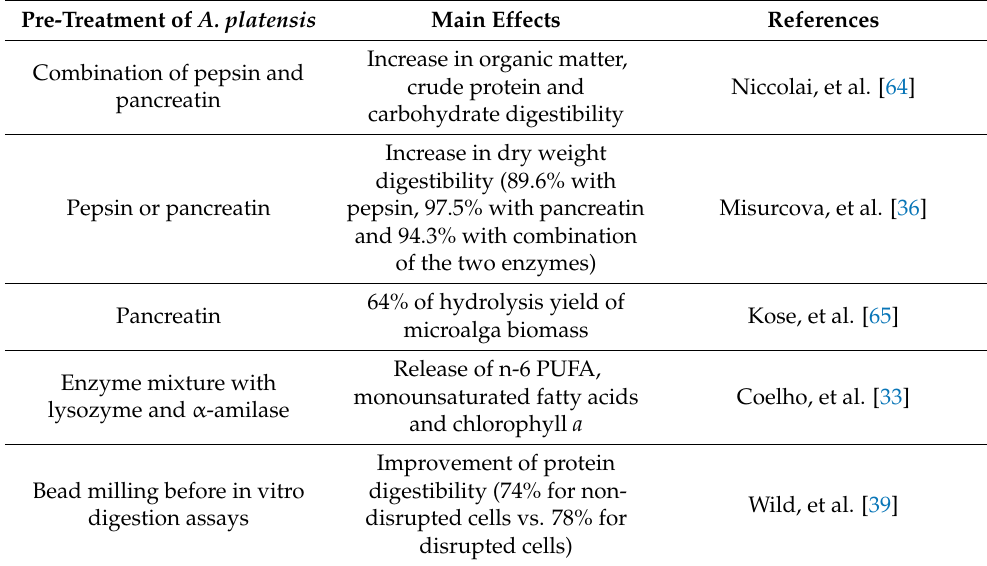
Table 3. Summary of main effects of in vitro pre-treatments on hydrolysis and digestibility of A. platensis